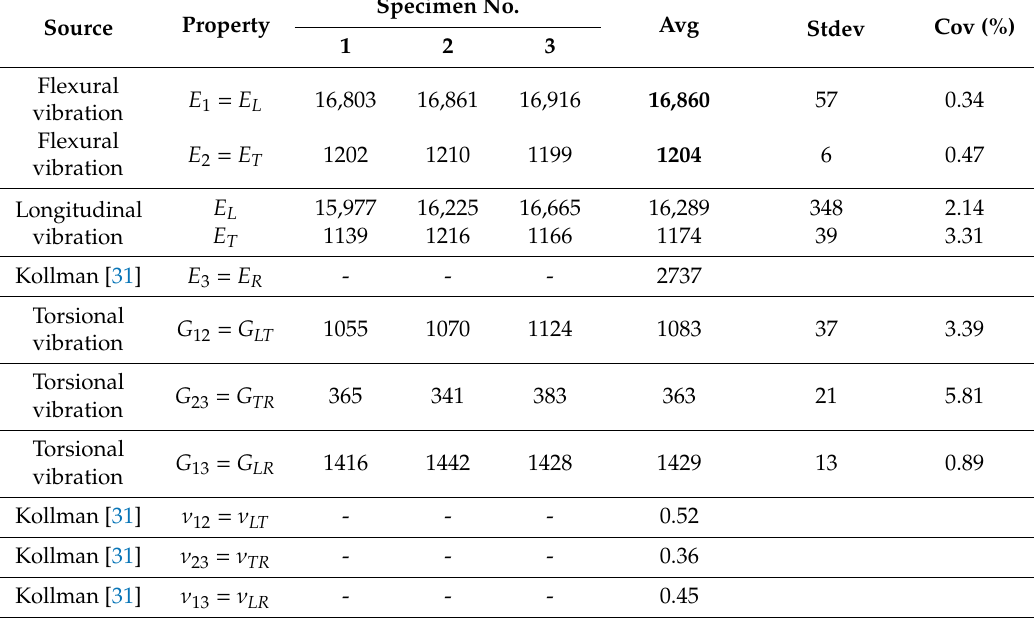
Table 3. Modulus of elasticity, shear modulus and Poisson’s ratio, determined from vibration tests and literature. Modulus of elasticity and shear modulus are in MPa. The values in bold type indicate data (only for E L ) that are used for subsequent calculations in finite element method and laminate